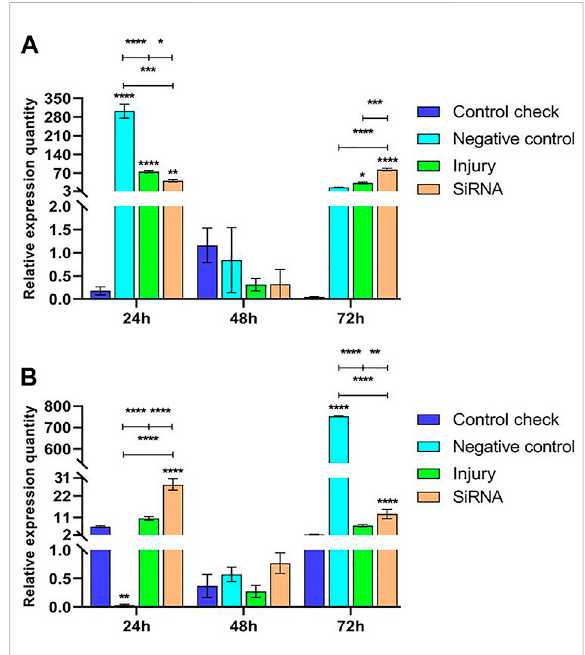
FIGURE 6 Effects of interfering target genes on Vitellogenin-3 gene expressionin Z.cucurbitae (Coquillett). (A) Interferingtargetgenes afterthe25 ° Ctreatmentfor1 h( F (3,24) =95.43, p < 0.0001; F (2,24) = 184.1, p < 0.0001; F (6, 24) = 110.9, p < 0.0001). (B) Interfering target genes after the 45 ° C treatment for 1 h ( F (3, 24) = 30,361 p < 0.0001; F (2, 24) = 32,129, p < 0.0001; F (6, 24) = 32,203, p < 0.0001). All values in the fi gure are presented as mean ± standard error. *, **, ***, and **** above the histograms indicate the values that differ signi fi cantly between treatments p ≤ 0.05, p ≤ 0.01, p ≤ 0.001, and p ≤ 0.0001,